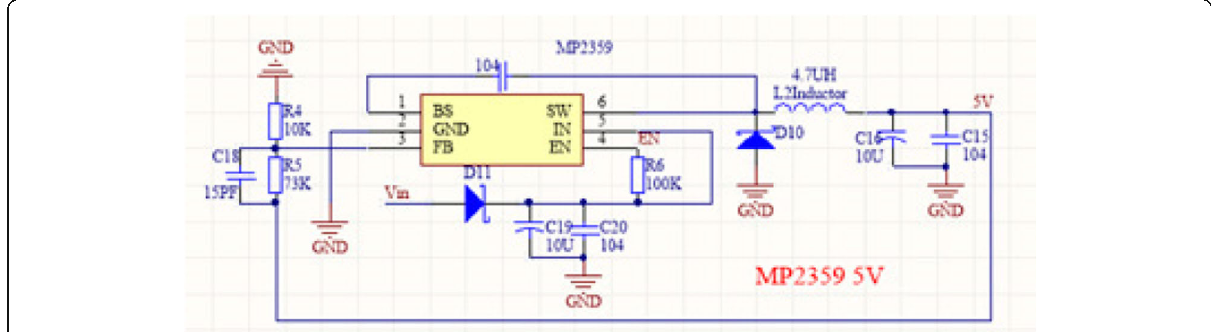
Fig. 25 The circuit structure of the MP2359 power supply